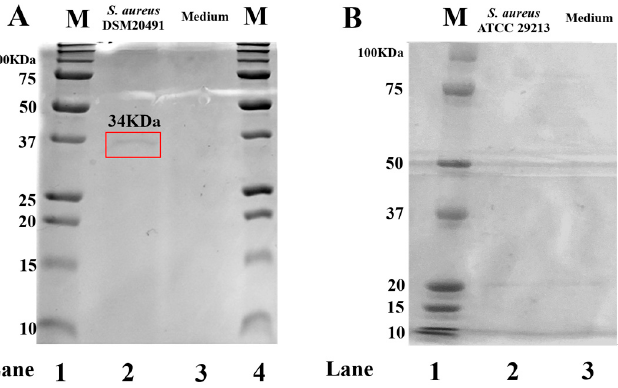
Figure 1. FCS qualitative analysis by SDS-PAGE. ( A ): Ladder ( lane 1 ) Precision Plus Protein™ Unstained Protein Standards (BIORAD cat.no 1610363); S. aureus DSM4020491 ( lane 2 ). ( B ): Ladder ( line 1 ) Precision Plus Protein™ Kaleidoscope™ Prestained Protein Standards (BIORAD cat.no